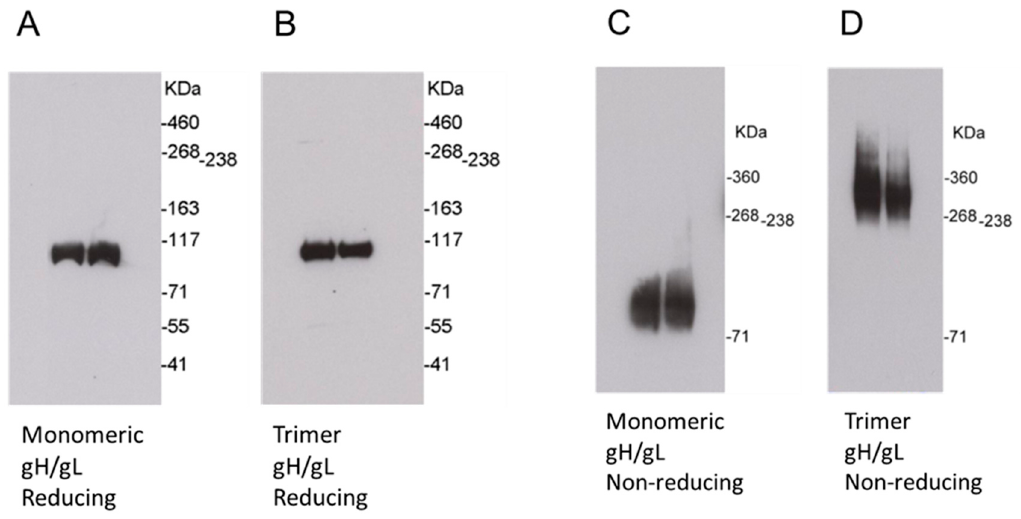
Figure 2. Western blot analysis of HCMV monomeric and trimeric gH/gL recombinant proteins under reducing and non-reducing conditions. Secreted proteins were purified with affinity purification and size exclusion chromatography from culture supernatants of stable Chinese hamster ovary (CHO) cell lines. ( A ) and ( B ) Blots of HCMV monomeric and trimeric gH/gL recombinant proteins developed with an anti-HCMV gH monoclonal antibody under reducing conditions. ( C ) and ( D ) Blots of HCMV monomeric and trimeric gH/gL recombinant proteins developed with an anti-HCMV gH monoclonal antibody under non-reducing conditions.